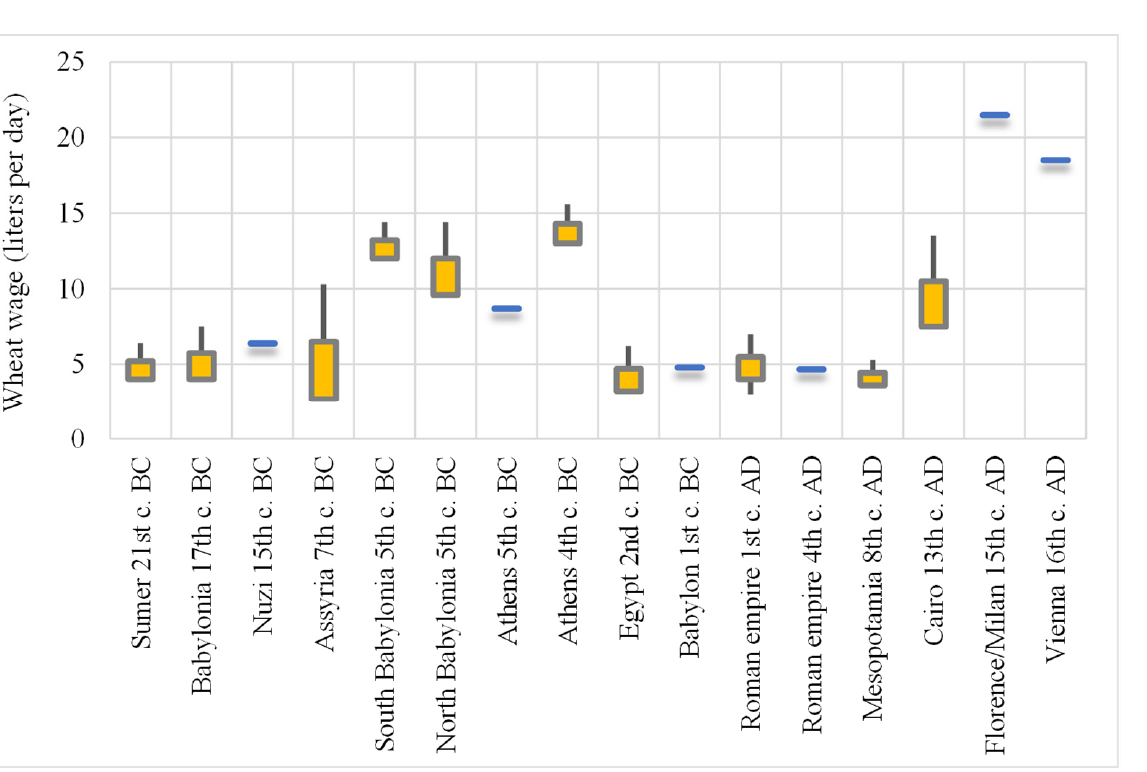
Figure 7. Average wheat wages of unskilled laborers in preindustrial societies.